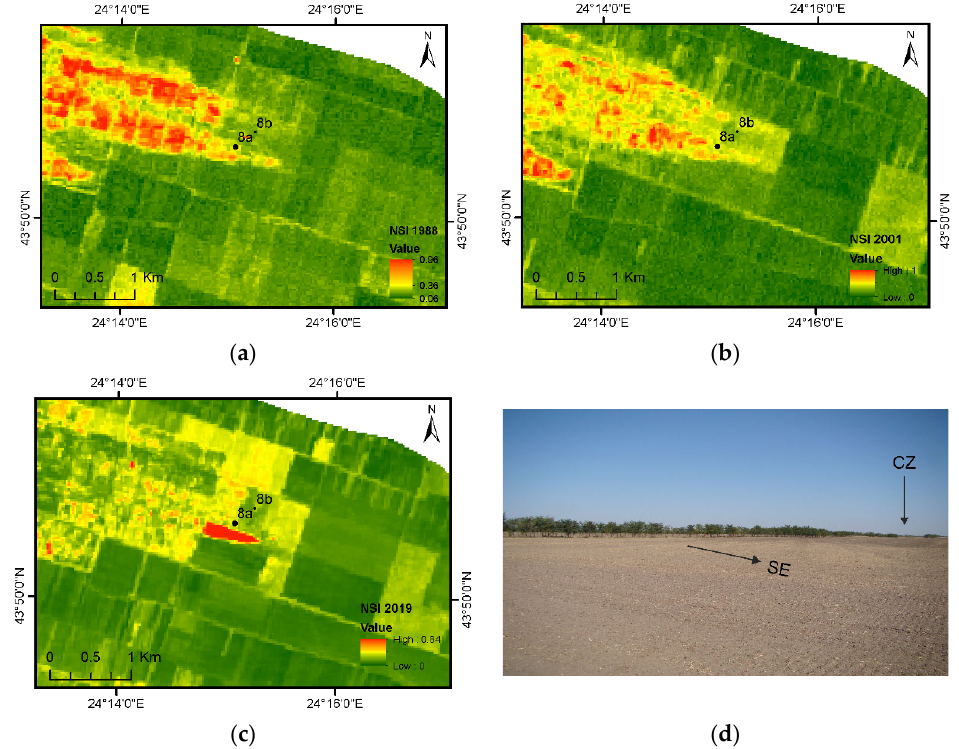
Figure 10. Evolution of sands evidenced by NSI in the vicinity of points 8a and 8b in 1988 ( a ), 2001 ( b ), and 2019 ( c , d ).